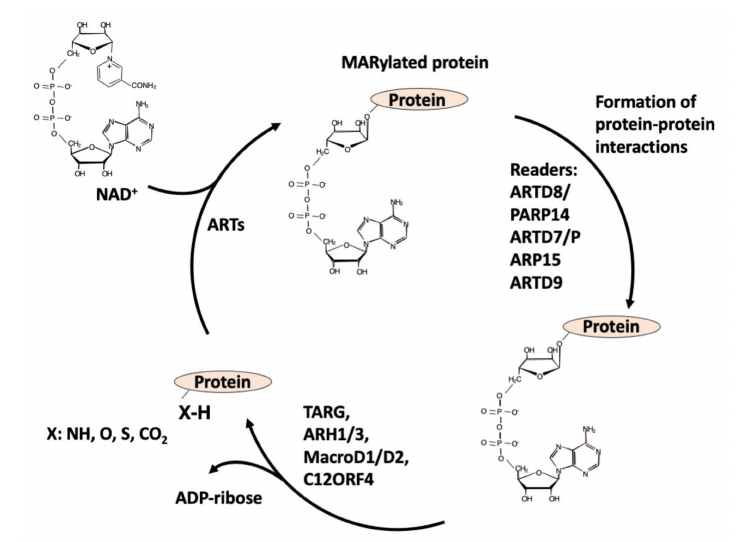
Figure 1. Writers, readers, and erasers of MARylation of proteins.